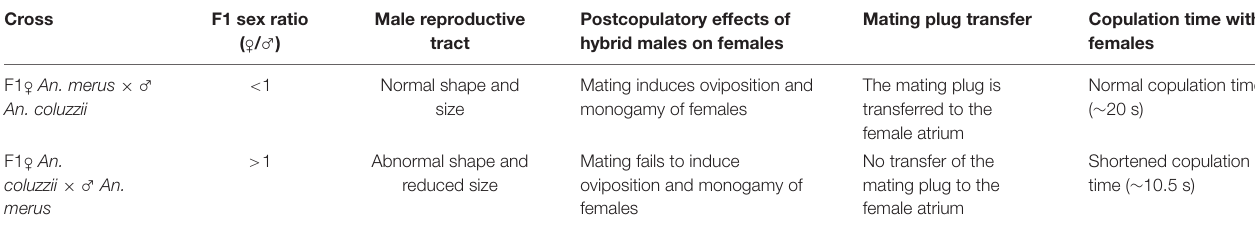
TABLE 2 | Asymmetric phenotypes of inter-species hybrids in the An. gambiae complex. Cross F1 sex ratio